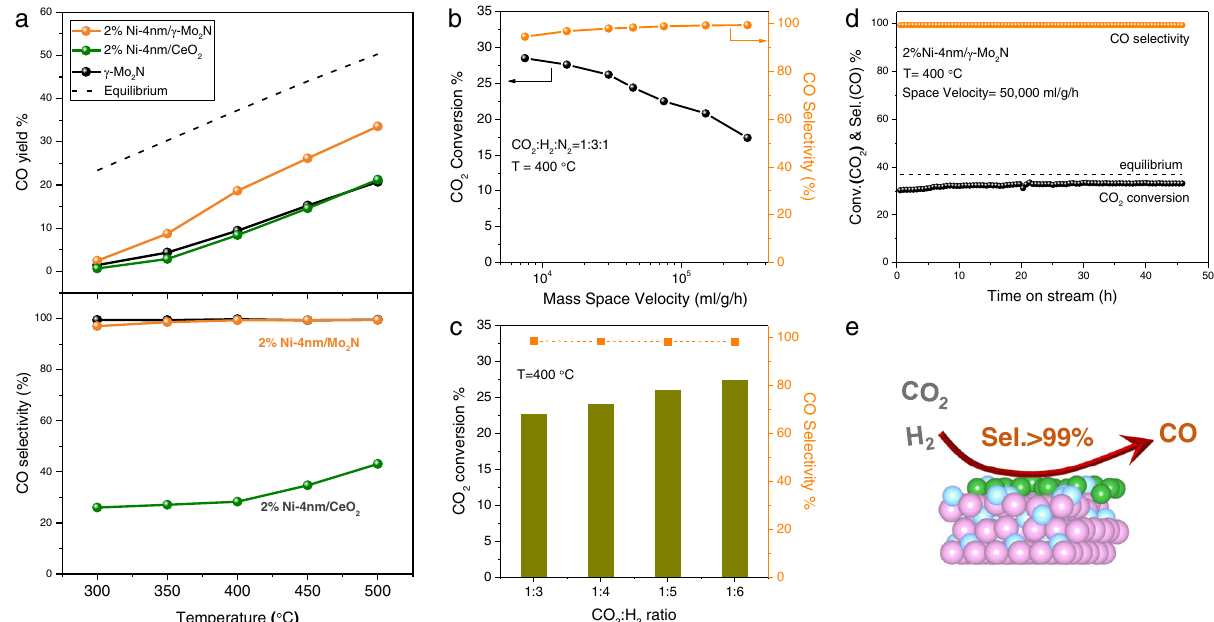
Fig. 7 Effect of reaction conditions on CO 2 hydrogenation over the Ni-4nm/ γ -Mo 2 N catalysts. a Effect of temperature on CO 2 hydrogenation over Ni- 4nm/ γ -Mo 2 N, Ni-4nm/CeO 2 , and γ -Mo 2 N catalysts (CO 2 :H 2 :N 2 = 1:3:1, GHSV = 300,000 mL g cat − 1 h − 1 ); Effect of b varied mass space velocity at a ratio of CO 2 :H 2 :N 2 at 1:3:1 and c varied CO 2 /H 2 ratio at reaction temperature of 400 °C; d the stabilities evaluation of Ni-4nm/ γ -Mo 2 N catalysts in the CO 2 hydrogenation ( T = 400 °C, CO 2 :H 2 :N 2 = 1:3:1, GHSV = 50,000mL g cat − 1 h − 1 ); e The schematic illustration of CO 2 hydrogenation over layered Ni-4nm/ γ - Mo 2 N. In this fi gure, the green, pink, and light blue atoms are Ni, Mo, and N